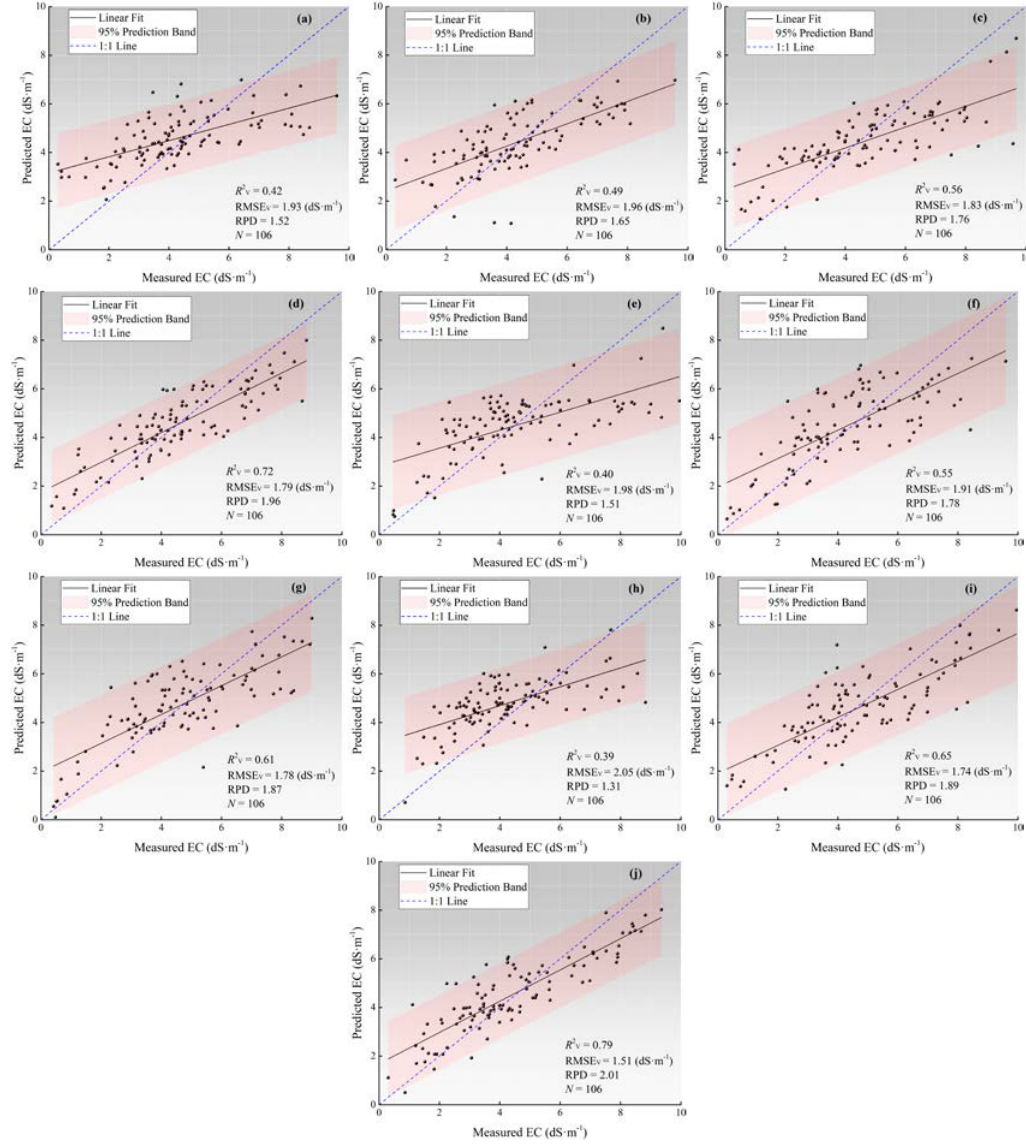
Figure 13. The scatter plot of measured versus predicted EC. ( a ) the result of Raw-I-PLSR model, ( b ) the result of Raw-II-PLSR model, ( c – h ) the results of (I-VI) PLSR models, ( i ) the result of α -PLSR model, and ( j ) the result of β -PLSR